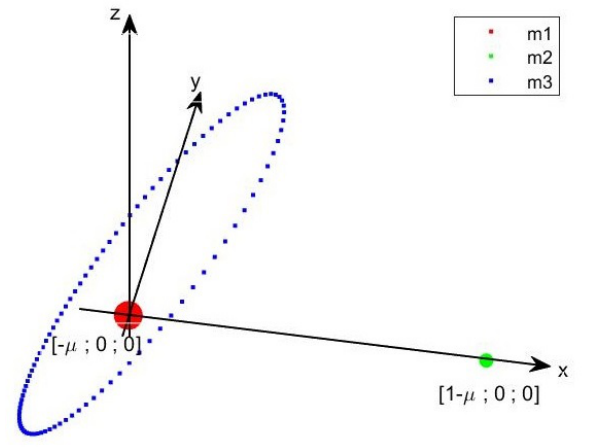
Figure 2. Motion of the primaries in rotating-pulsating coordinates. Only one orbit of m 3 is shown. Introducing the normalization factors for the mass M = (cid:113) R 2 and time T = , allows transforming the rotating coordinates into rotating-pulsating G M ones ( x , y , z ) , and, finally, rearranging System (2) in a dimensionless form, with the depen- dence on time being replaced by that on θ [38]